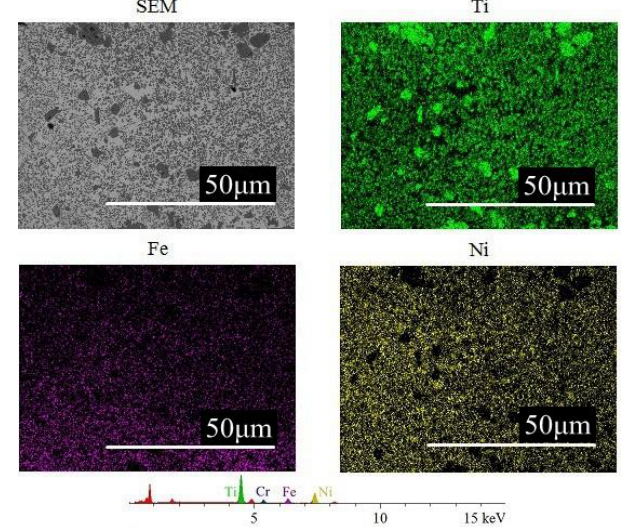
Figure 6. Elements analysis on the cladding layer cross section (1.5 kW laser power).